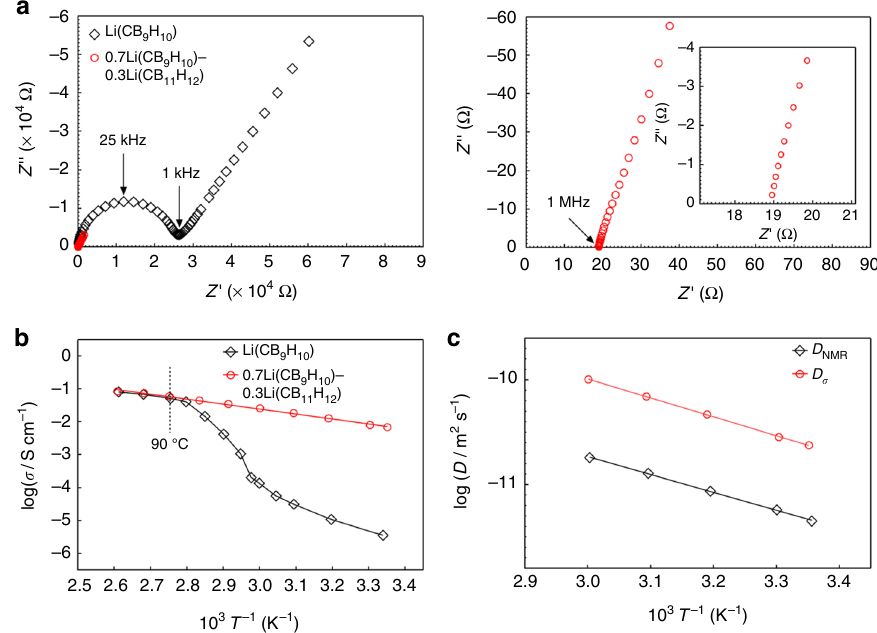
Fig. 2 Lithium ion conductivity of 0.7Li(CB 9 H 10 ) – 0.3Li(CB 11 H 12 ). a Nyquist plots of Li(CB 9 H 10 ) and 0.7Li(CB 9 H 10 ) – 0.3Li(CB 11 H 12 ) at 25 °C (left). Magni fi ed Nyquist plots of 0.7Li(CB 9 H 10 ) – 0.3Li(CB 11 H 12 ) in the high-frequency region (right). b Arrhenius plots of the lithium ion conductivities of Li(CB 9 H 10 ) and 0.7Li(CB 9 H 10 ) – 0.3Li(CB 11 H 12 ). c Arrhenius plots of the diffusion coef fi cients calculated from the impedance and NMR